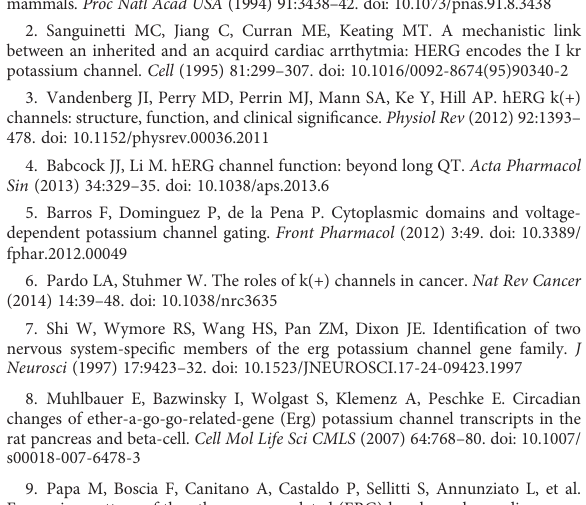
SUPPLEMENTARY FIGURE 3 (A) Blood glucose in WT and tolbutamide-treated WT mice. (B) Blood glucose in Kcnh6- b -KO and tolbutamide-treated Kcnh6- b -KO mice. n=5 for each group. *P < 0.05, **P < 0.005 vs. Ctrl. Statistical comparisons were calculated using the Mann – Whitney U test (A, B)